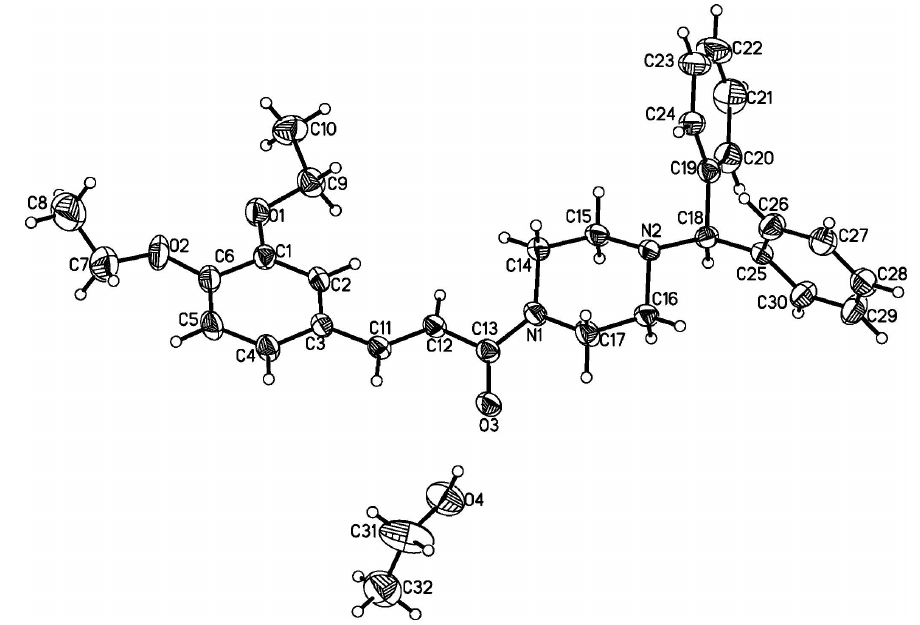
Figure 1 The molecular structure and numbering scheme of the title compound. Displacement ellipsoids for non-H atoms are drawn at the 50% probability